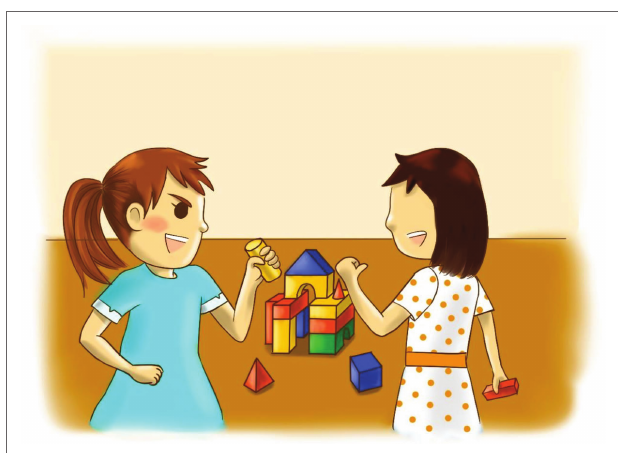
FIGURE 2 | Pictorial achievement goal item for girls to measure other- approach